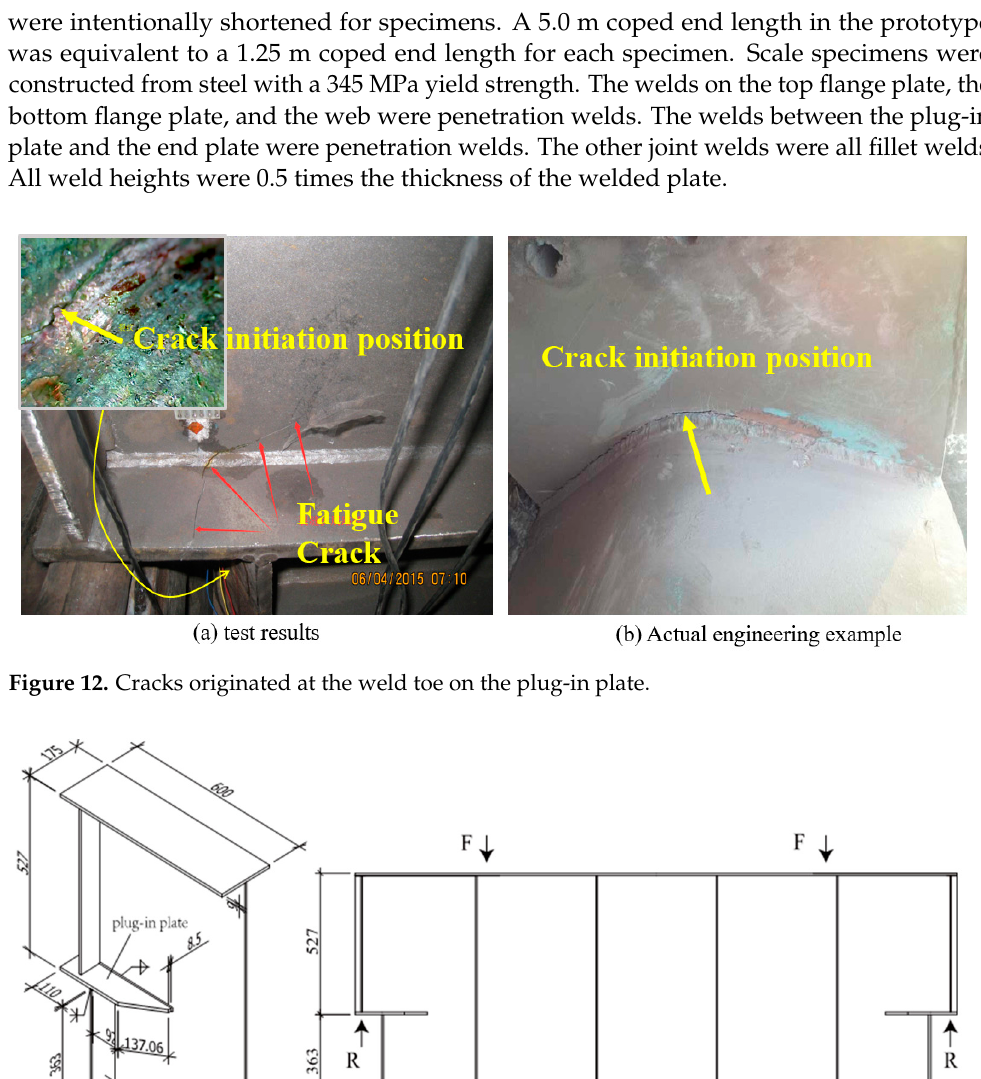
Figure 13. Dimensions of the variable-section supports with right-angle end plates.